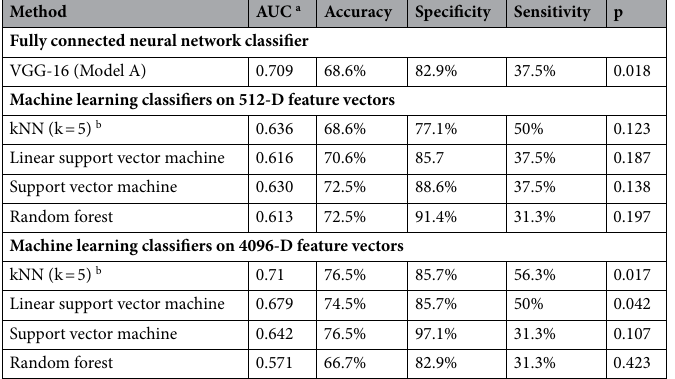
Table 3. Histology prediction probabilities for neural network classifier vs CNN-derived feature-based classifiers. a Area under the ROC curve. ADC histology corresponds to the “positive” class. b k number of specified nearest neighbors, an even